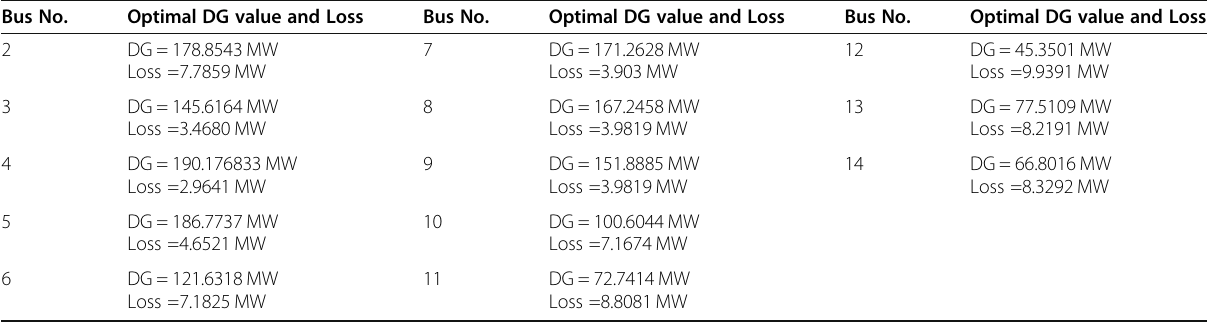
Table 11 Optimum solution for the IEEE 14 bus system with DG individually injected at each bus using JAYA algorithm Bus